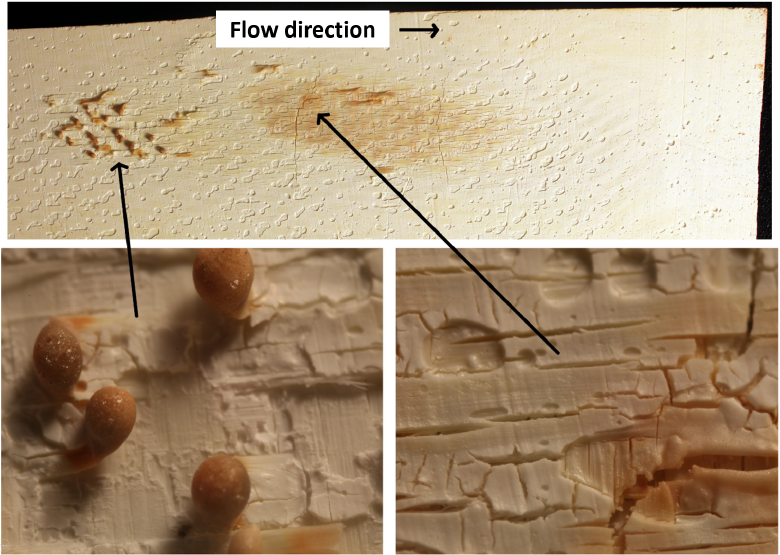
Figure 18. The material sample ( top ) shows fibre melting ( bottom left ) and cracks ( bottom right ) in the area affected by the burner—the latter result from thermal stresses when the already damaged material cools down